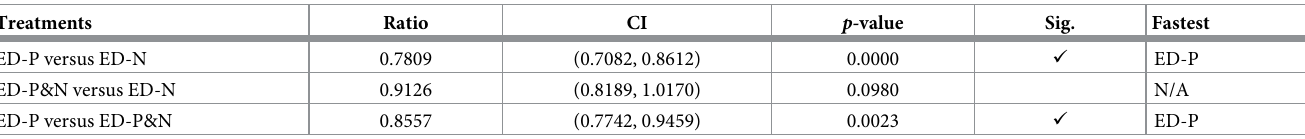
Table 4. ED : Overall time analysis.